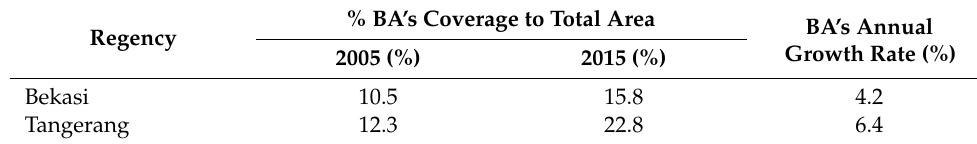
Growth Rate (%)2005 (%) 2015 (%)